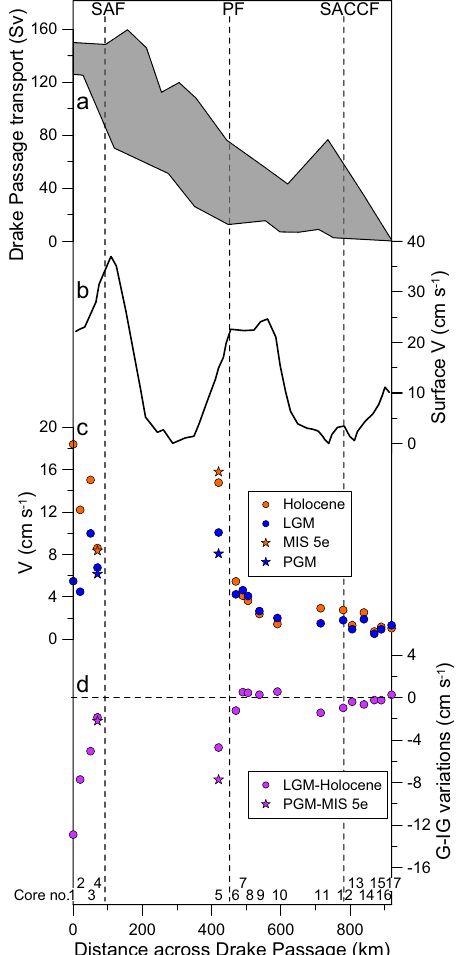
Fig. 3 Comparison of the ACC fl ow speeds in the Drake Passage region. a Range of modern Drake Passage cumulative volume transport from south to north along Jason Track 104 36 and SR1b 69 . b Mean cross-track surface geostrophic velocities 36 . c Bottom fl ow speeds are transferred by the latest calibration in the Drake Passage region 26 and the new SSFS fl ow speed proxy explained in Supplementary Fig. 6. Orange and blue dots mark ACC fl ow speeds during the Holocene and LGM 5 – 8 , respectively. Orange and blue stars indicate fl ow speed in the Drake Passage during the MIS 5e and PGM, respectively. d Glacial-interglacial (G-IG) fl ow speed differences associated with frontal system. Larger glacial reductions of fl ow velocities are detected in north of the SAF (cores 1-4, see Table S2) 6 – 8 and the PF (core 5, this study) compared to small changes south of the PF (cores 6 – 17; 5 see Supplementary Table 2). SAF Subantarctic Front, PF Polar Front, SACCF southern ACC